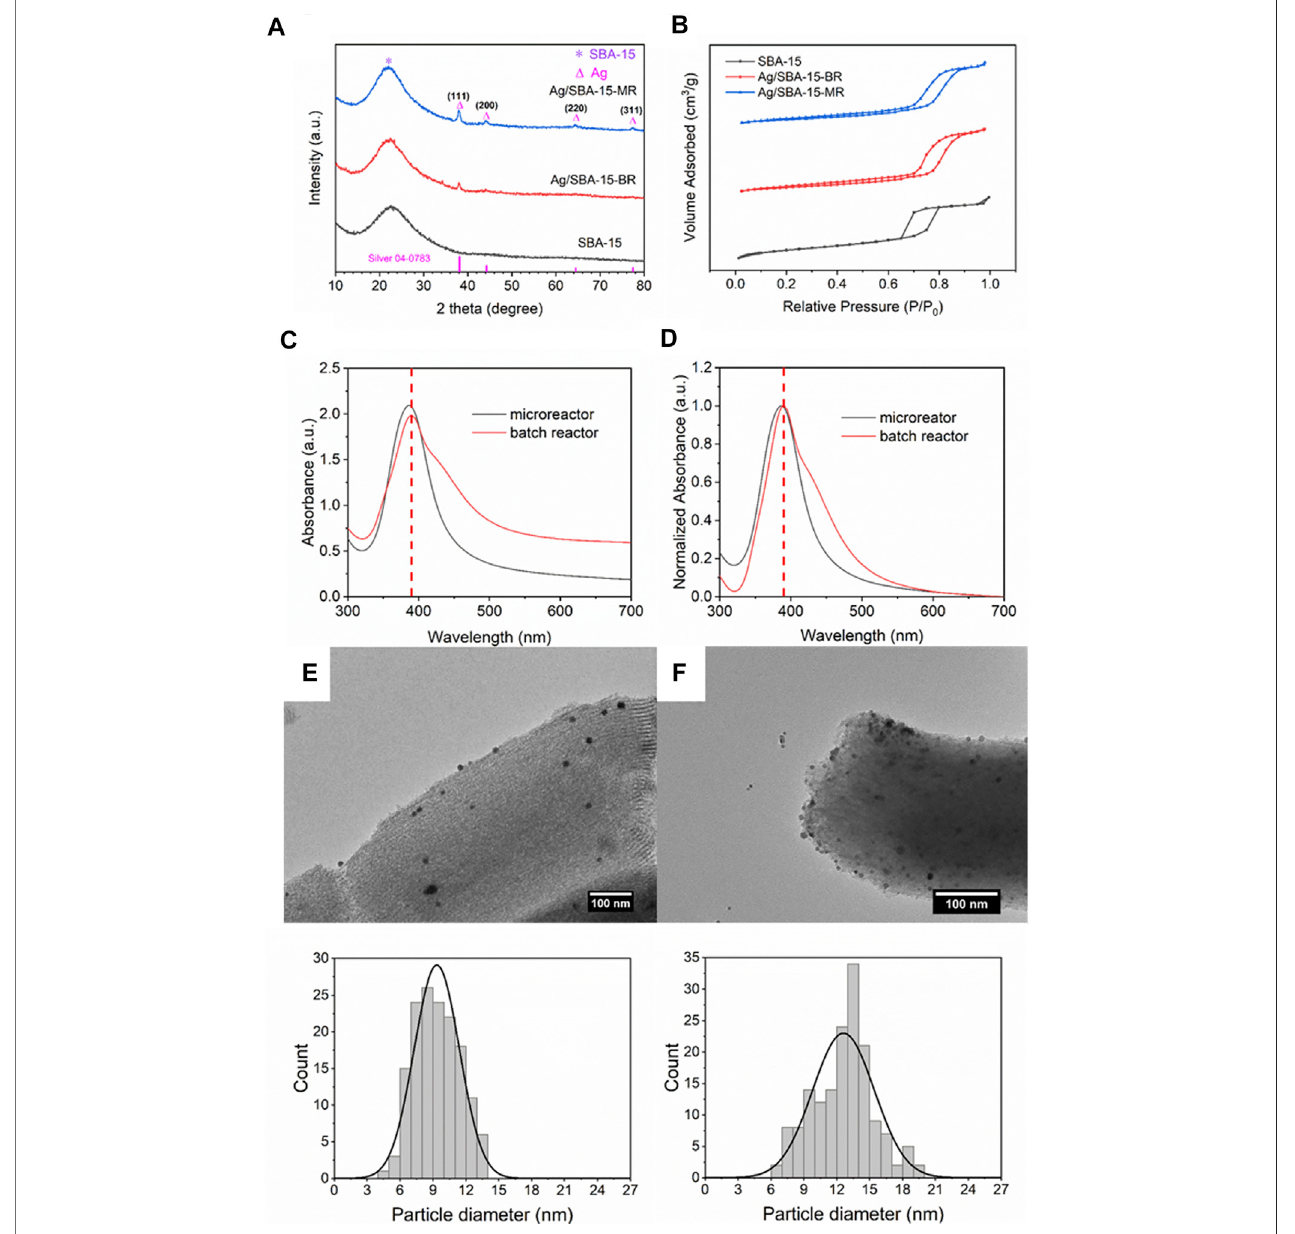
FIGURE 2 | (A) XRD patterns, (B) N 2 adsorption-desorption isotherms, (C) UV-Vis absorbance spectra and (D) normalized absorbance spectra of Ag/SBA-15 synthesized inacoiled fl owinverter microreactor and abatchreactor. TEMimages and sizedistributionofsilver nanoparticles dispersed onSBA-15 synthesized in (E)